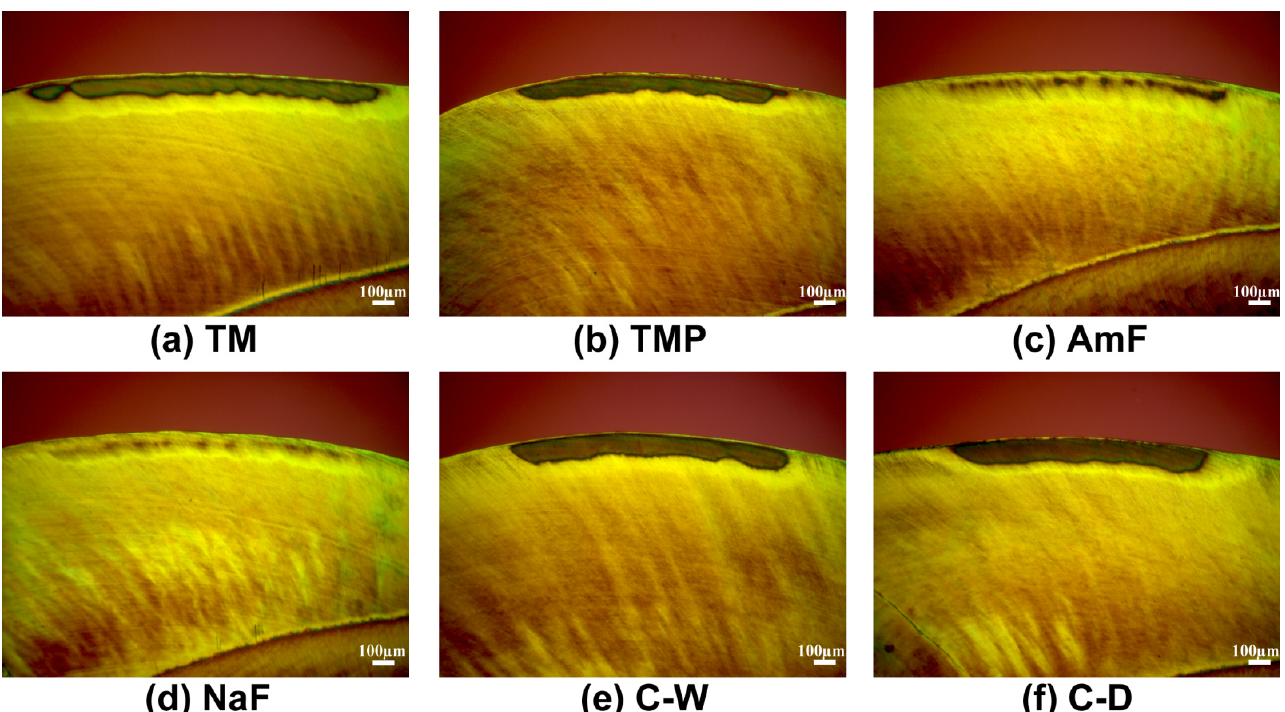
Figure 5. Polarized light images of enamel lesions showing different lesion depths caused by the protective influence of treatment with different toothpaste slurries (a-d) during artificial demineralization compared to controls (e,f).